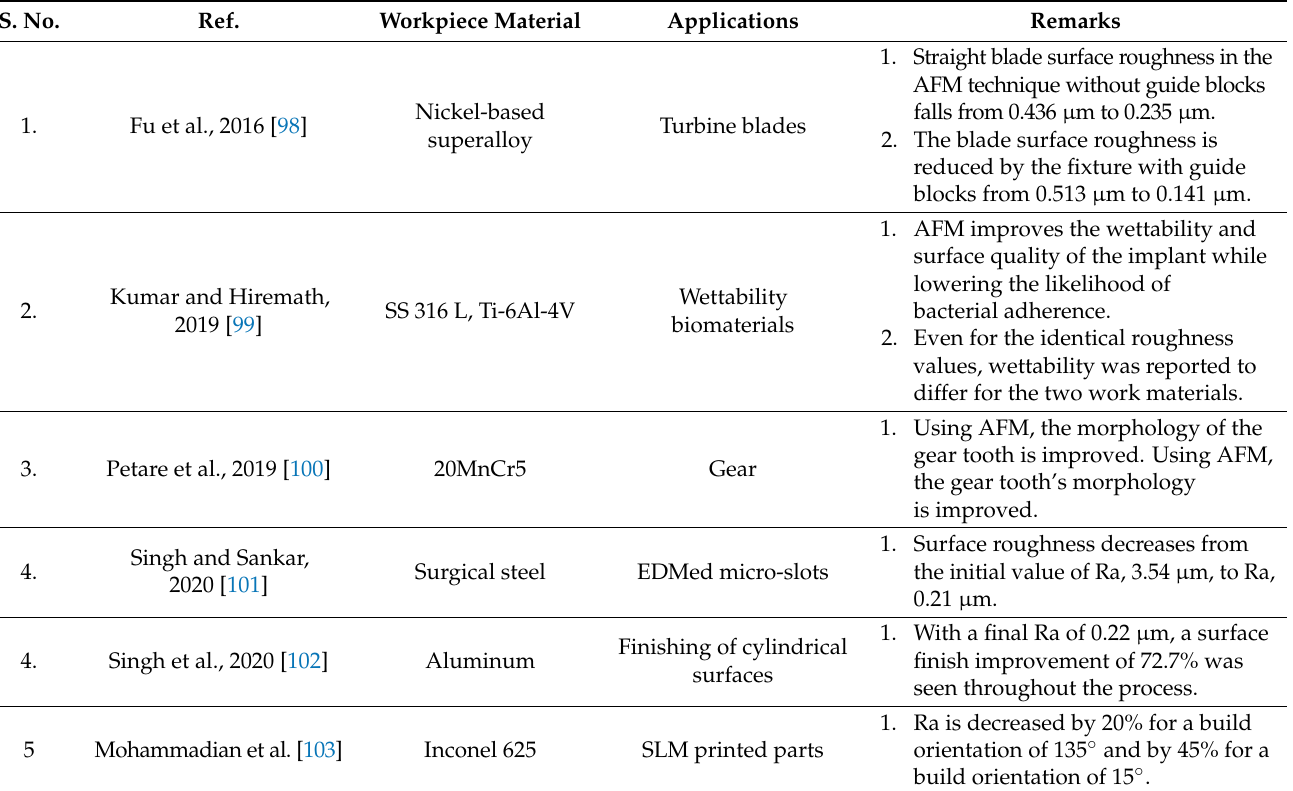
Table 4. A summary of the differences and similarities of the different AFM process